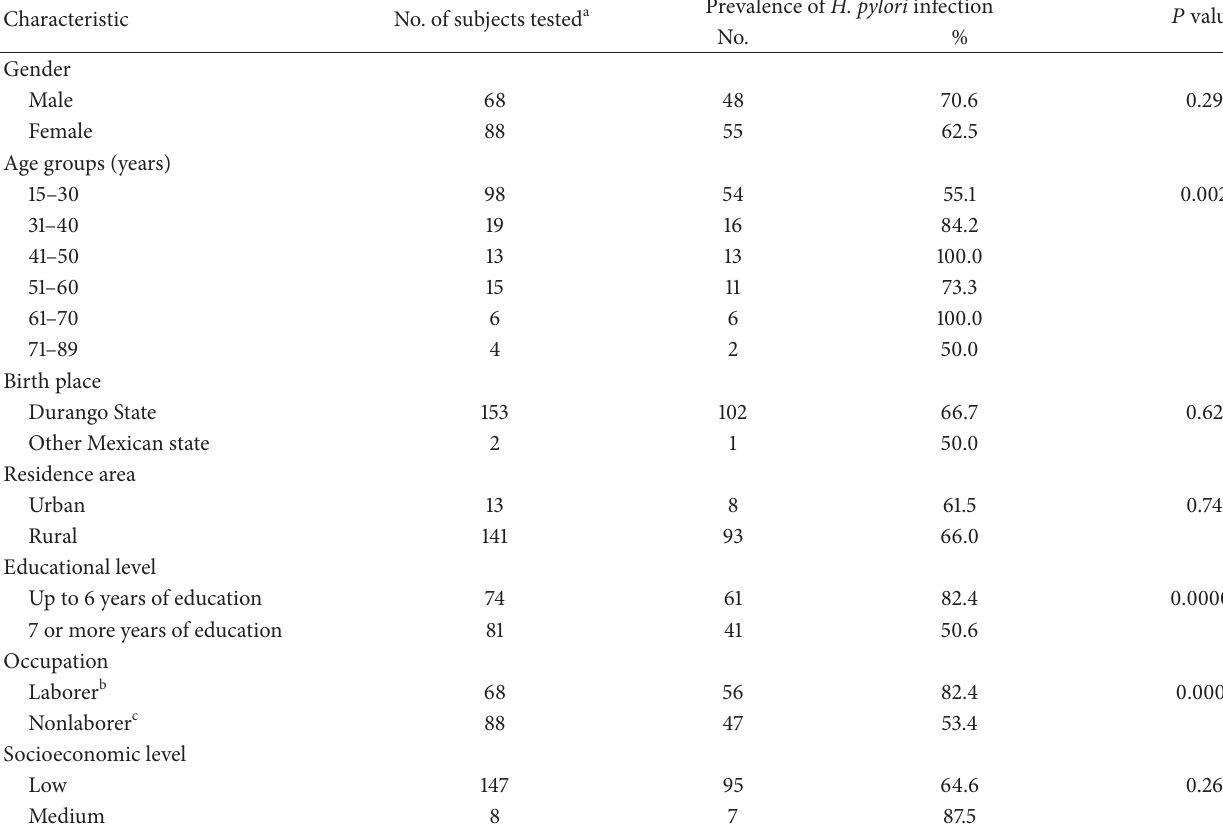
Table 1: Sociodemographic characteristics of Tepehuanos and seroprevalence of H. pylori infection.